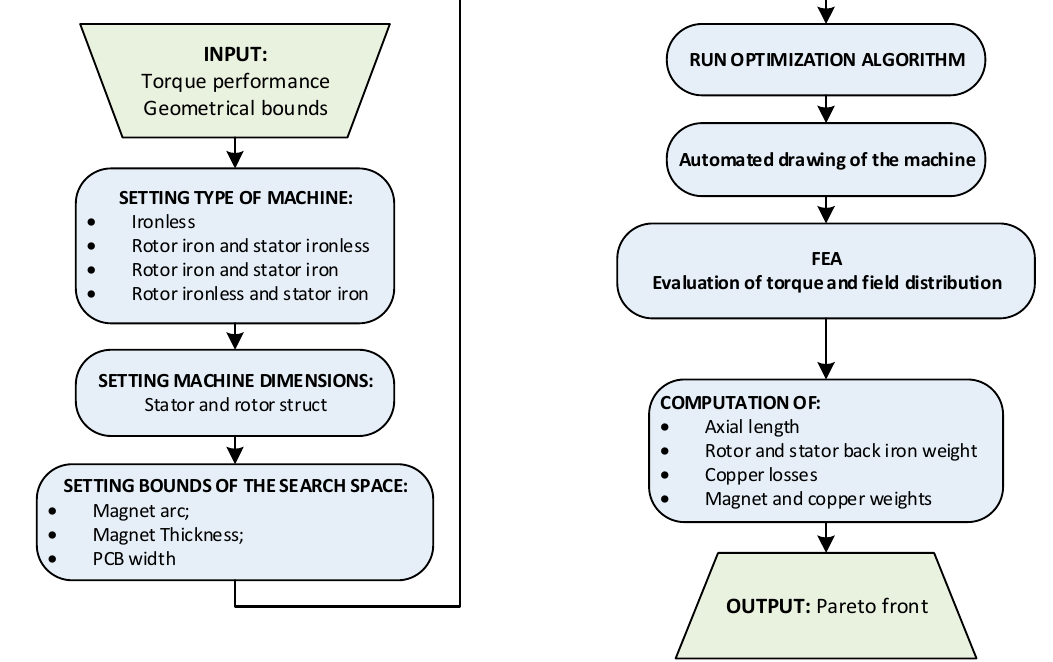
Figure 11 . Flowchart of the proposed design procedure. Figure 11. Flowchart of the proposed design procedure.